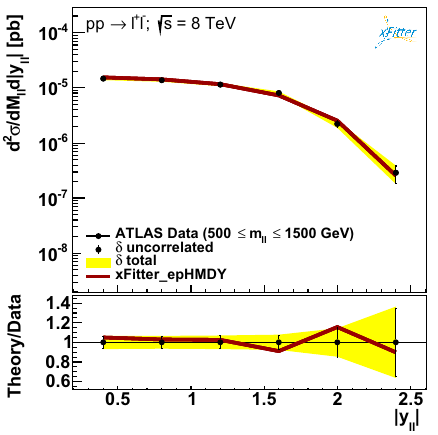
Fig. 5 Same as Fig. 3 for the highest m ll bin